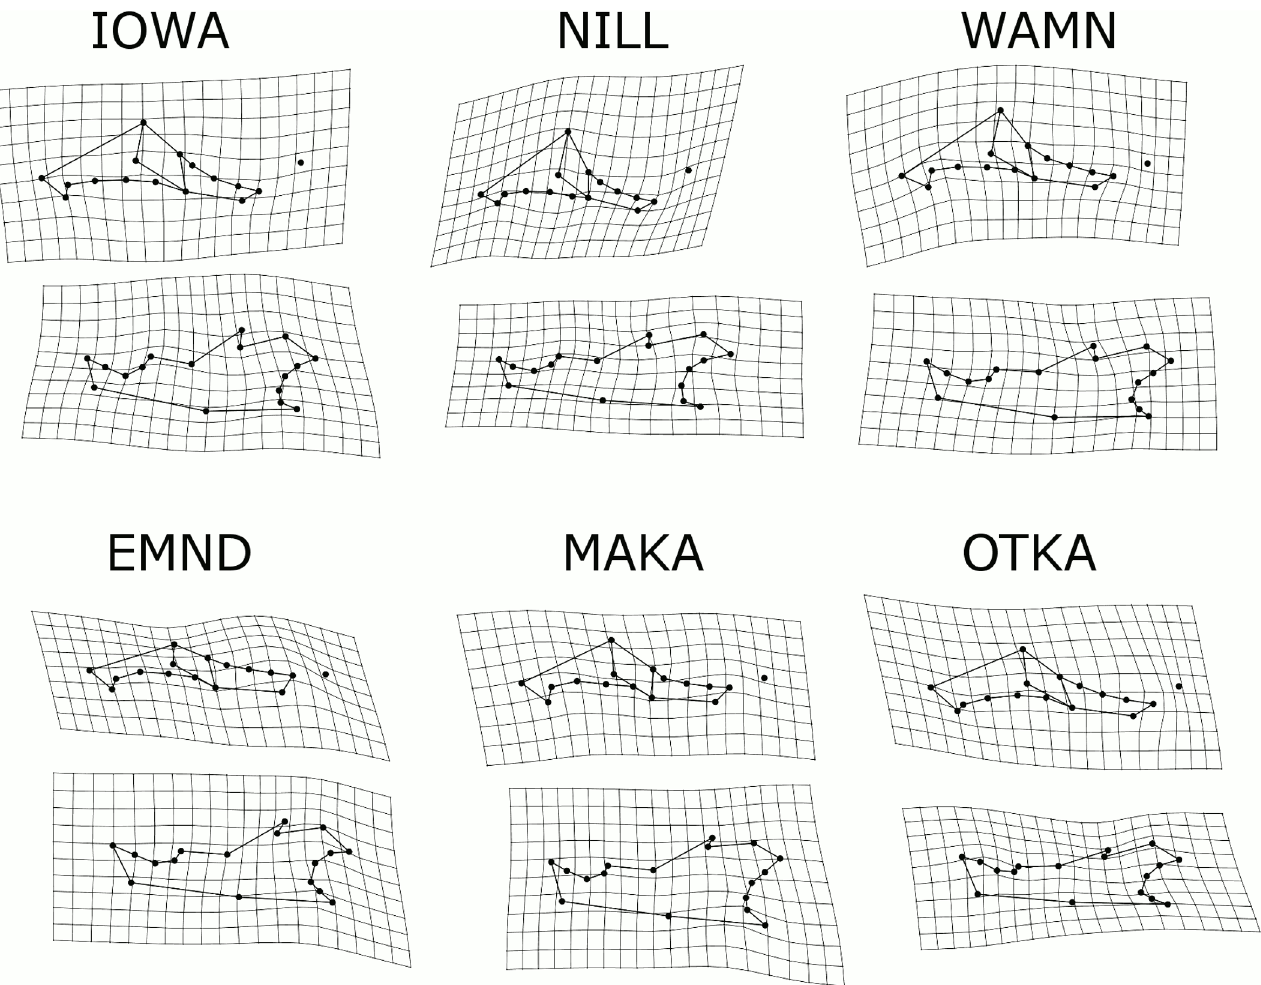
Fig 6. Location-specific changes in Peromyscus maniculatus bairdii jaw shape. Thin plate spline (TPS) deformation grids illustrate the changes in shape that have occurred in each location from approximately 1910 to 2012. TPS grids represent a hypothetical change in shape, based on required bending energies associated with making changes to a 2-dimensional object using the least amount of force. If an object is compared to itself, all lines would be parallel or perpendicular to all other lines, and all grid squares would be of equal size. These TPS grids are shown at 3x magnification to clarify changes. Parallel lines represent no change between objects, and all non-parallel lines represent a change in shape. Also, lines further apart represent a relative widening of that region relative to the rest of the structure, whereas lines that are closer together represent a relative shrinking of that region. Landmarks are as in Fig 2 and specimens are as described in Table